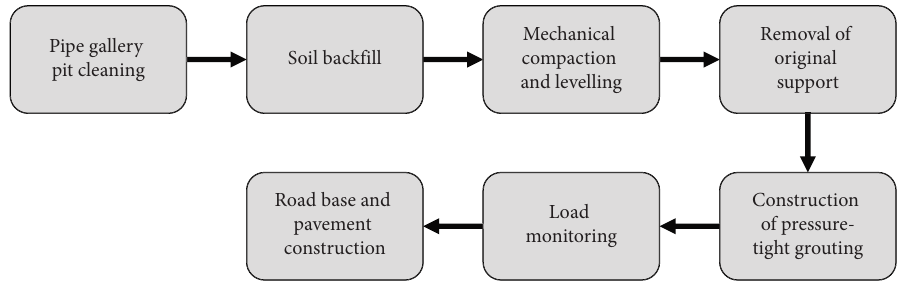
Figure 1: Proposed backfll construction